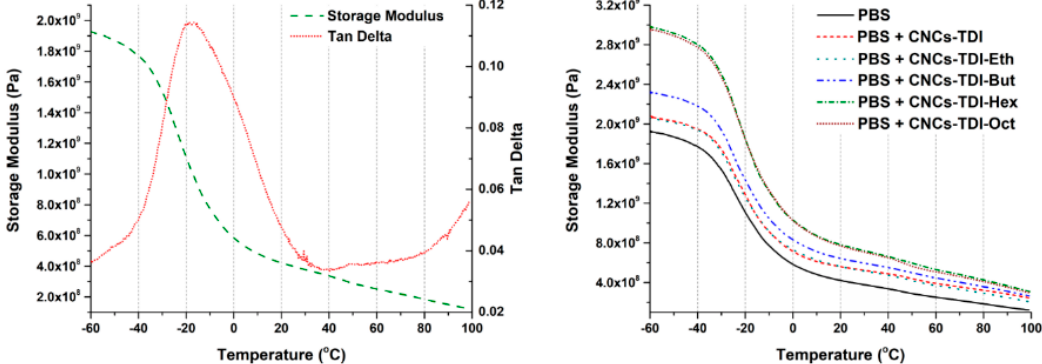
Figure 8. The dynamic mechanical analysis (DMA) results of the neat and reinforced PBS samples showing the glass transition temperature of PBS at around − 17 °C ( Left ) and the effect of the surface modification of CNCs on their reinforcement capabilities ( Right ). Table 3. The DMA and TGA results for the reinforced PBS compared to the neat one.